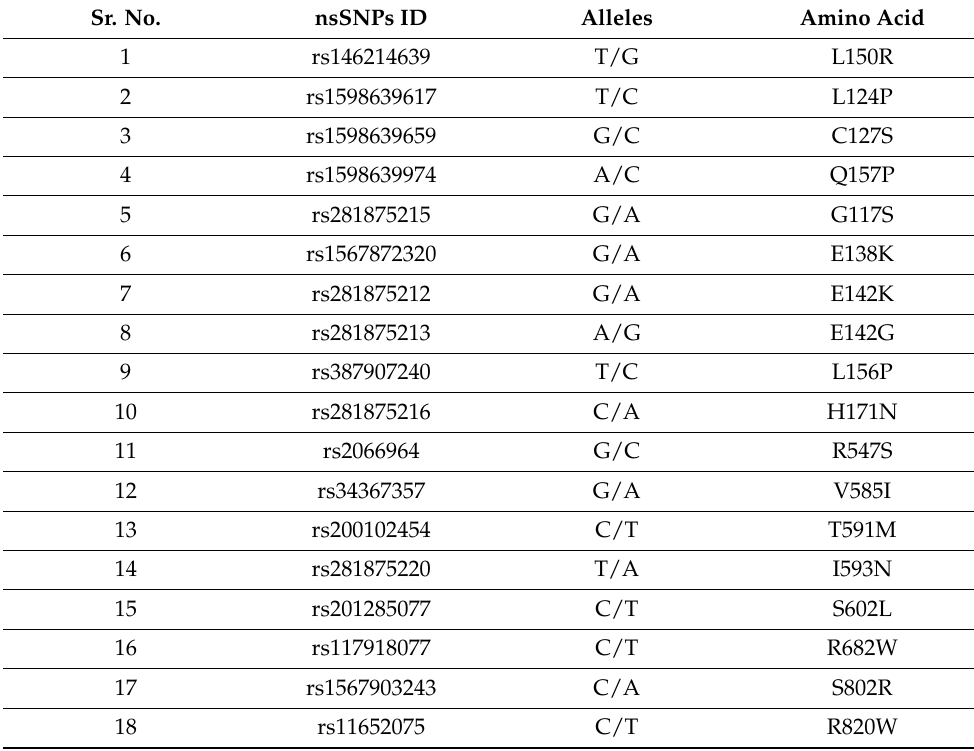
Table 1. List of CARD14 nsSNPs genotyped in this study. Sr.